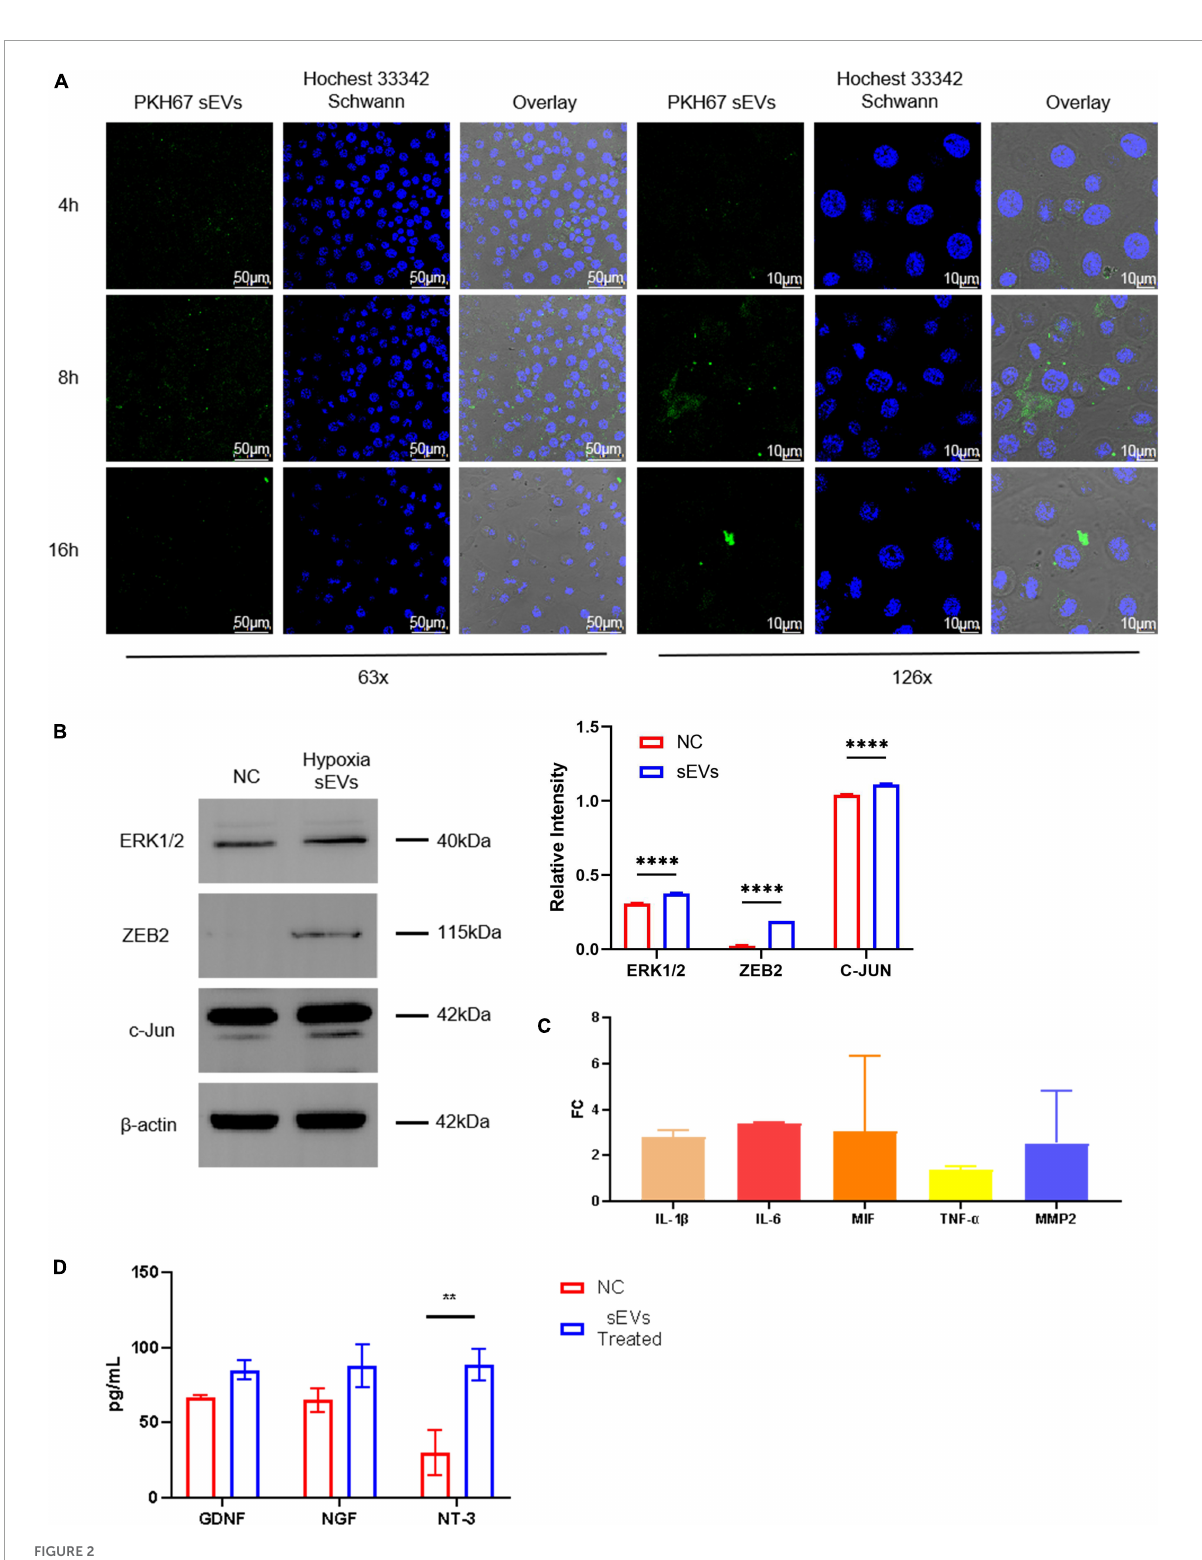
FIGURE2 Cellular localization and uptake of fluorescently labeled sEVs with SCs. (A) Cellular colocalization: SP8 was used to photograph sEVs prelabeled with PKH67 (green fluorescence) with Hoechst 33,342 (blue fluorescence)-stained SC nuclei. (B) Western blot: Detection of ERK1/2, ZEB2, and c-JUN expression levels in NC Schwann cells and after 48-h treatment with hypoxia sEVs. (C) Real-time PCR: Inflammatory and other restoration-related factors (IL-1 β , IL-6, TNF- α , etc.) were detected. (D) ELISA test: GDNF NDF and NT-3 in the supernatant of Schwann cell preparation. Statistical significance, * p < 0.05,** p < 0.01, and **** p < 0.0001. ∗ Significant